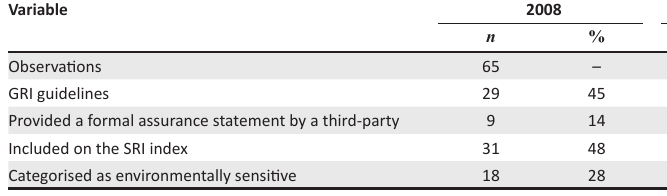
TABLE 1: Descriptive statistics for the sample.